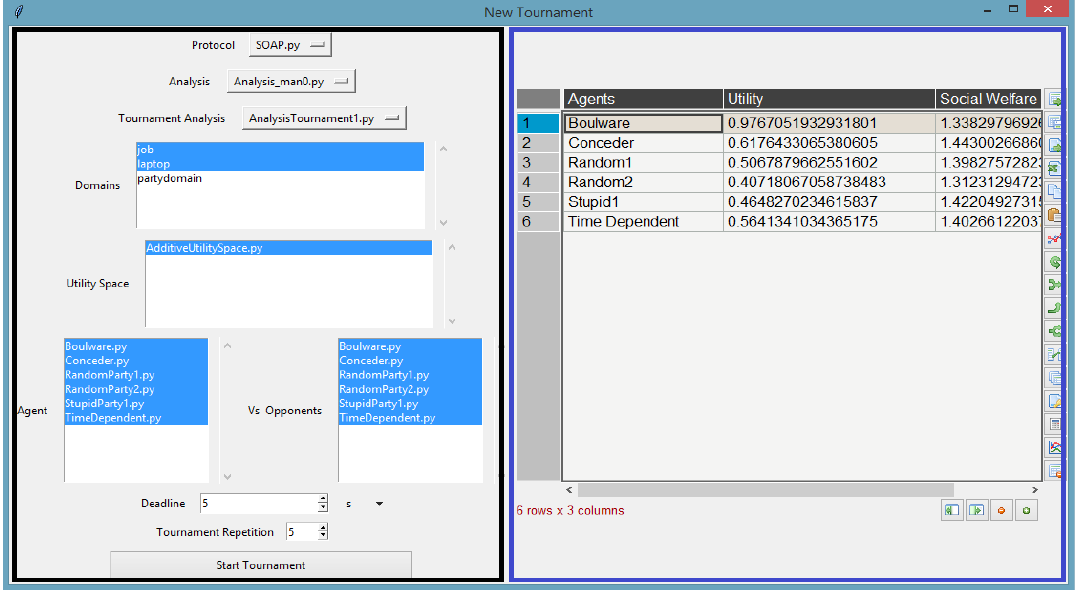
Figure 6. The tournament window has two main parts, the parameter setup (inside of black frame) and the results (inside of blue frame). The results are shown in a table, but it is easy to draw charts using the right sidebar of the results window.